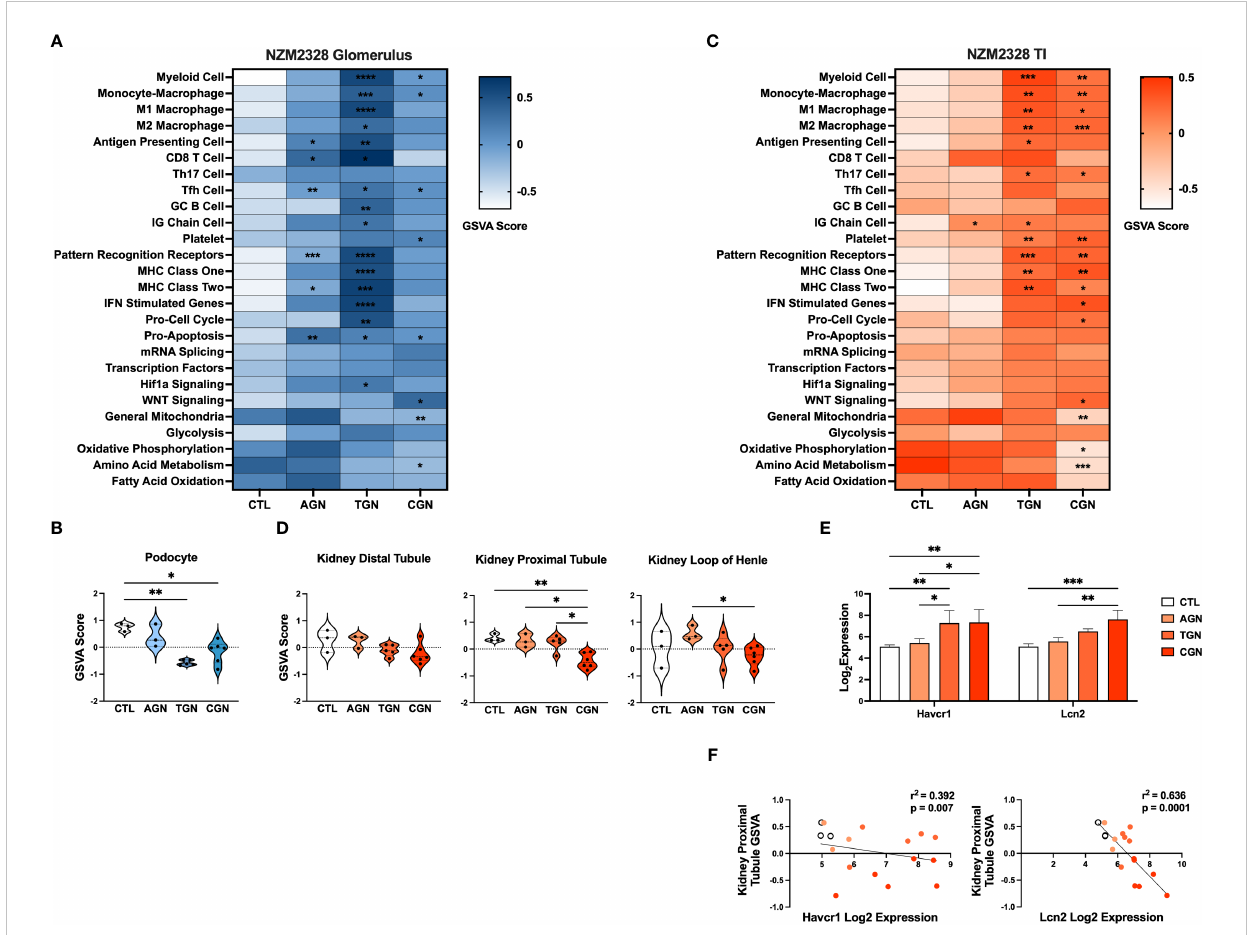
FIGURE 2 Transcriptomic analysis of GN disease stages in glomeruli and TI of NZM2328 mice. (A) Heatmap of GSVA scores for enrichment of immune cell and pathway gene signatures in glomeruli of CTL, AGN, TGN, and CGN mice. Asterisks indicate signi fi cant comparisons with CTL mice. (B) GSVA enrichment of podocytes in cohorts shown in (A) . (C) Heatmap of GSVA scores in the TI of cohorts shown in (A) . (D) GSVA enrichment of kidney tubule cell gene signatures in cohorts from (C) . (E) Log 2 expression values of kidney tubule damage-associated genes for cohorts from (C) . (F) Linear regression between log 2 expression of kidney tubule damage genes and GSVA scores of kidney tubule cells. *p<0.05, **p<0.01, ***p<0.001,